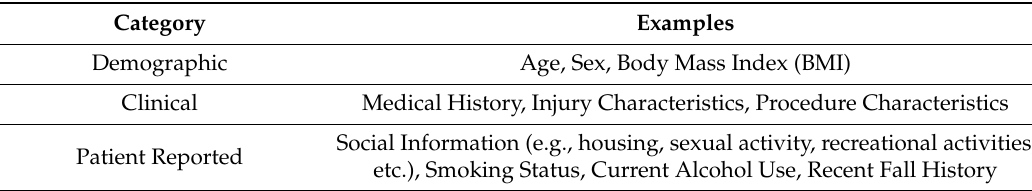
Table 2. Types of User Input Data.